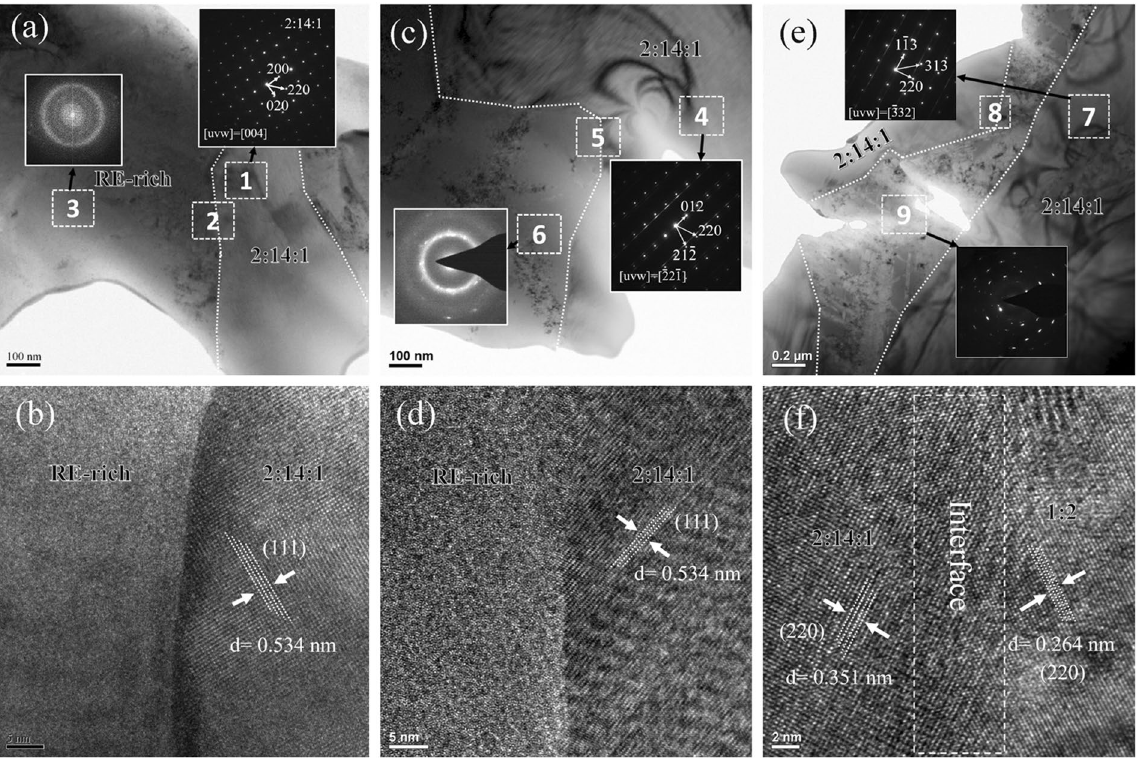
Figure 3. TEM images for the selected as-cast (Nd 1 − x Ce x ) 25 Fe 40 Co 20 Al 4 B 11 alloys ( a ), ( b ) x = 0; ( c , d ) x = 0.3; ( e , f ) x =